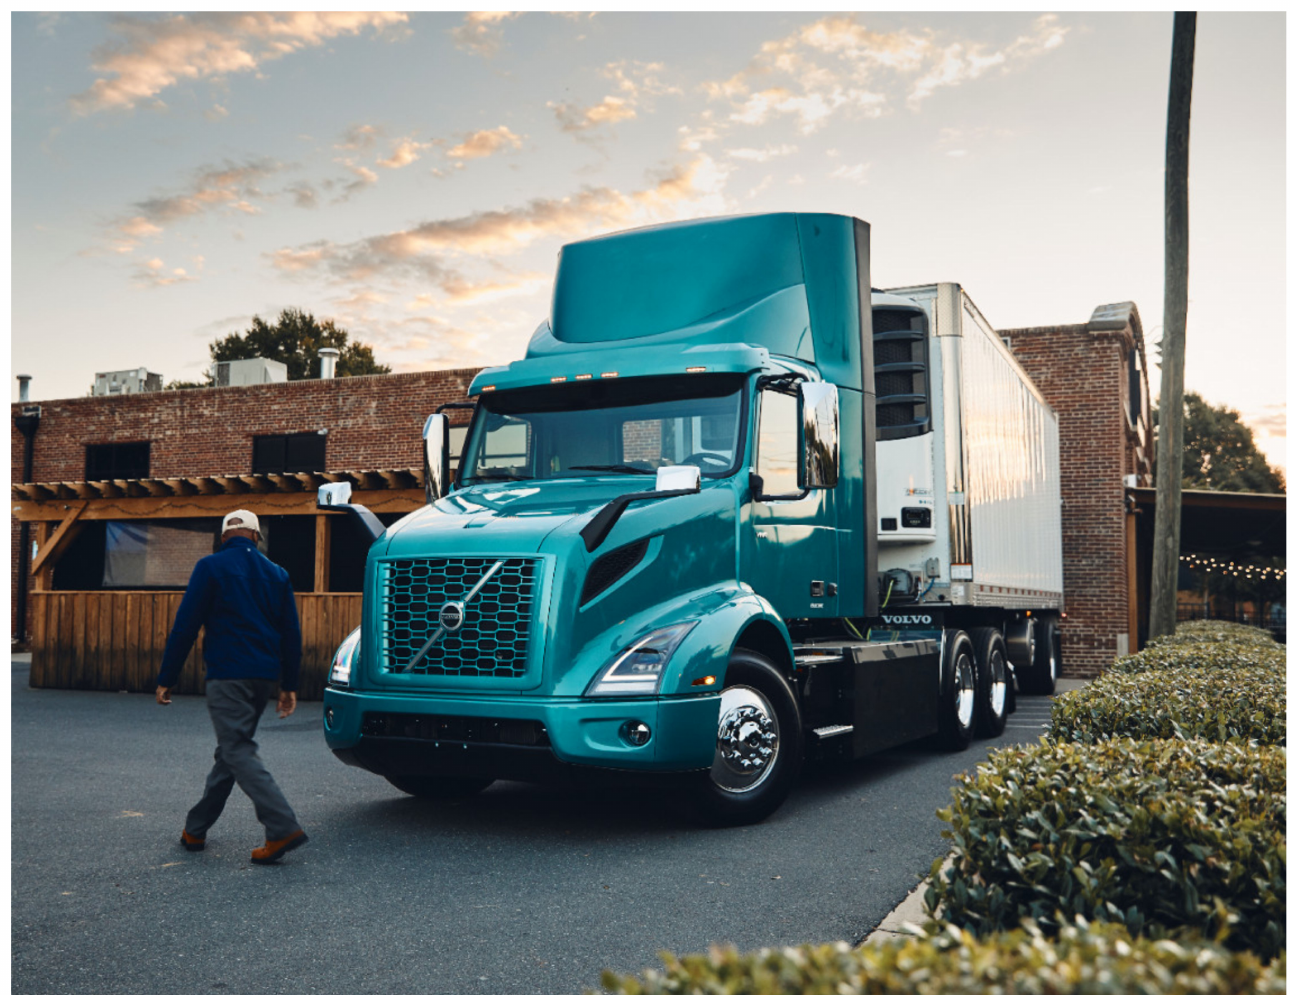
Figure 2. The Volvo VNR Electric model is currently being used in day-to-day, revenue-generating customer